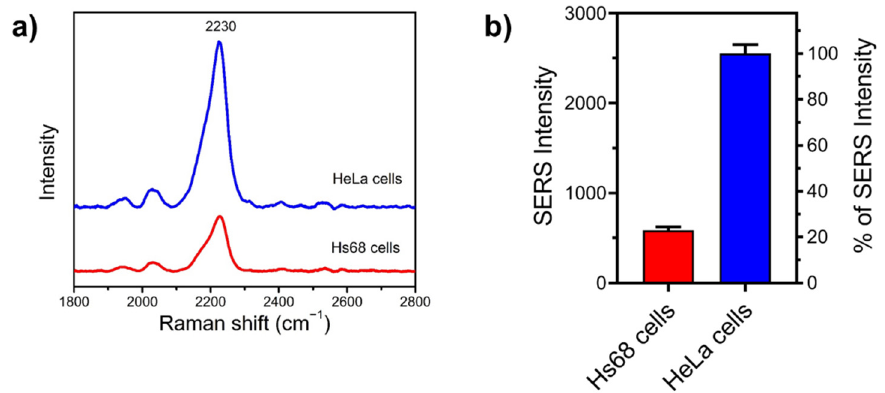
Figure 5 . ( a ) SERS spectra were obtained from Hs68 cells and HeLa cells that were pretreated with